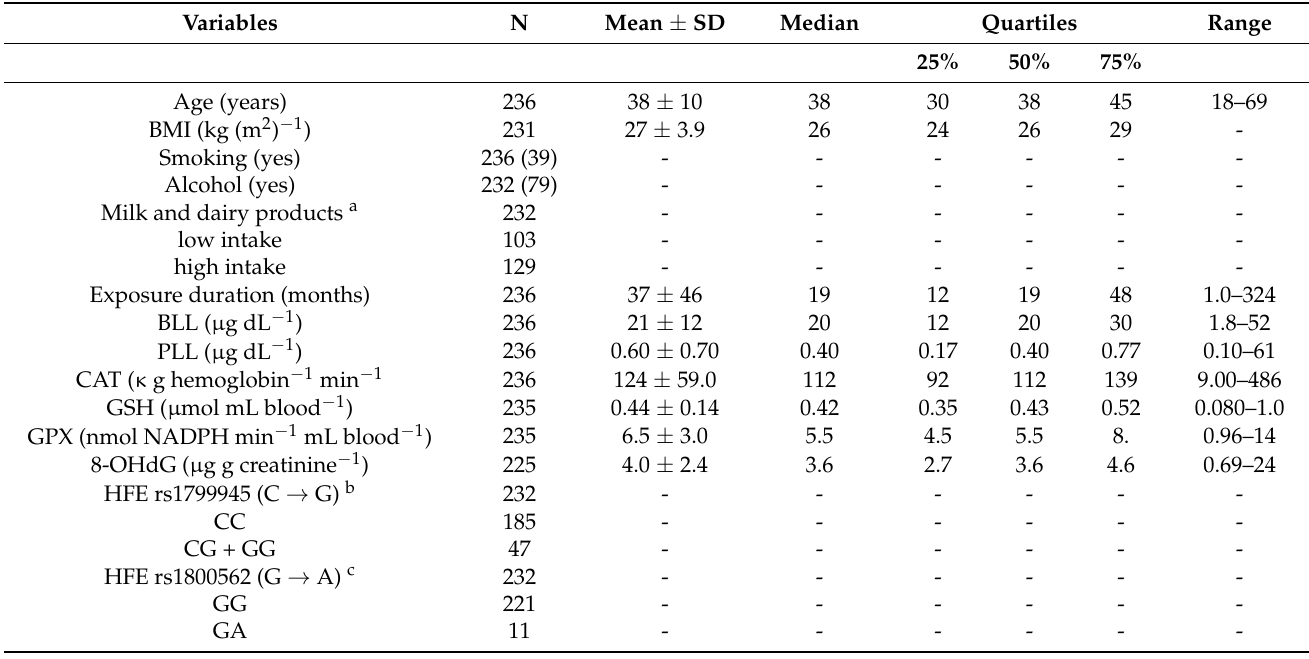
Table 1. General characteristics of the study